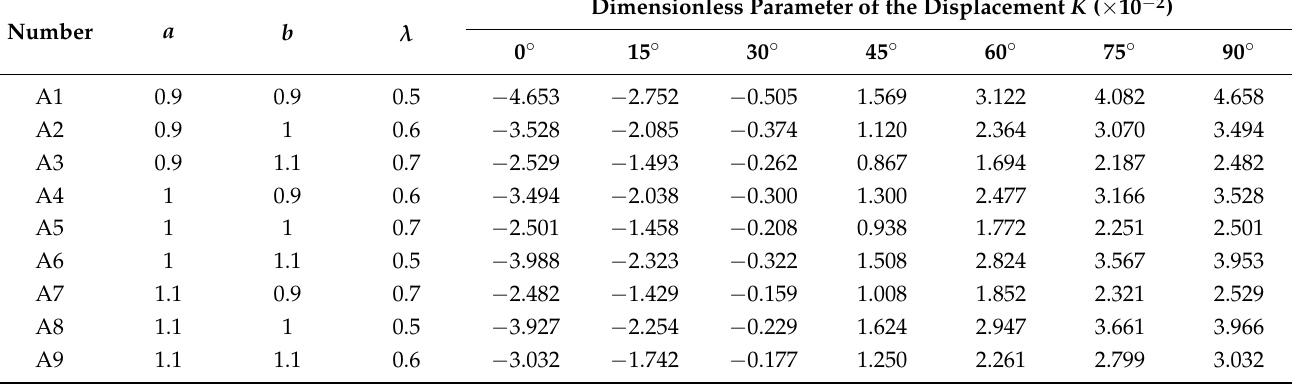
Table 4. Radial displacement of functionally graded